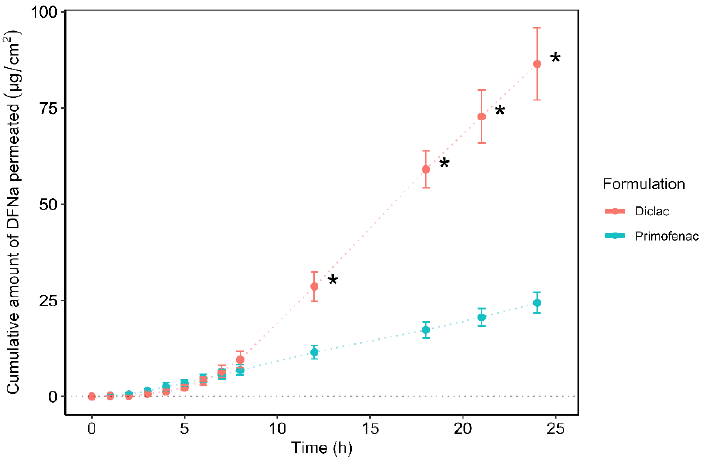
Figure 1. Cumulative permeation of DFNa over time for various commercially available formulations in human epidermis ( n = 5; mean ± SD, * p < 0.05).